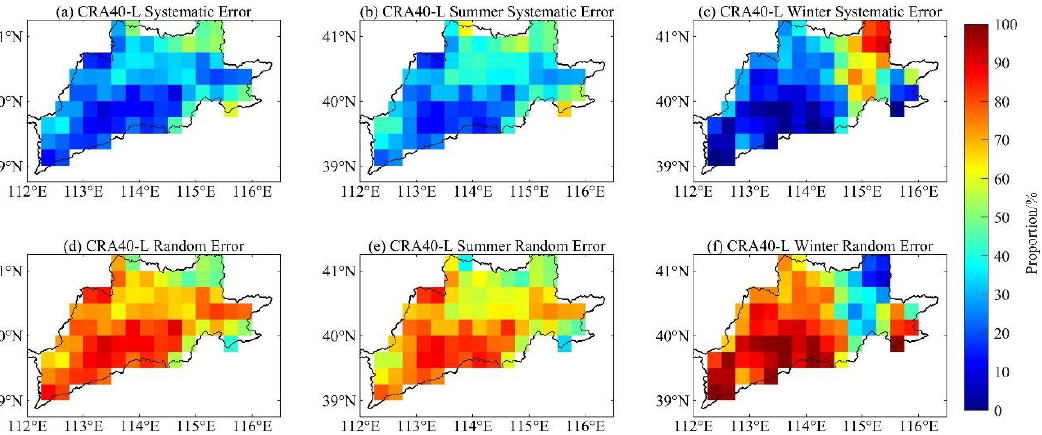
Figure 4. ( a – f ) Systematic and random error components (%) of the CRA40-Land reanalysis precip- itation data.